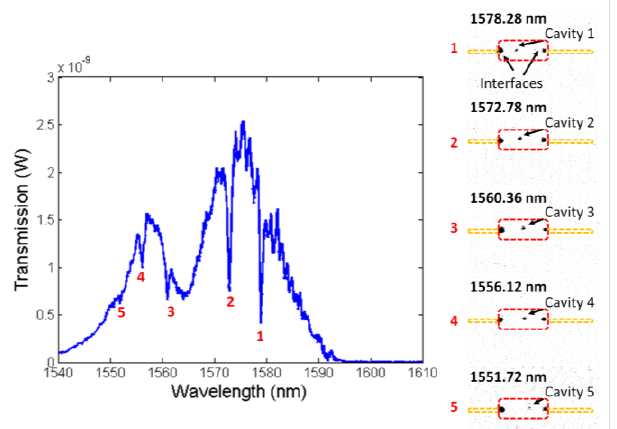
Figure 2. Transmission spectrum (end-fire measurements) of five-cavity array in water highlighting each resonance and image of light scattered from each cavity location on resonance (inverted colours).